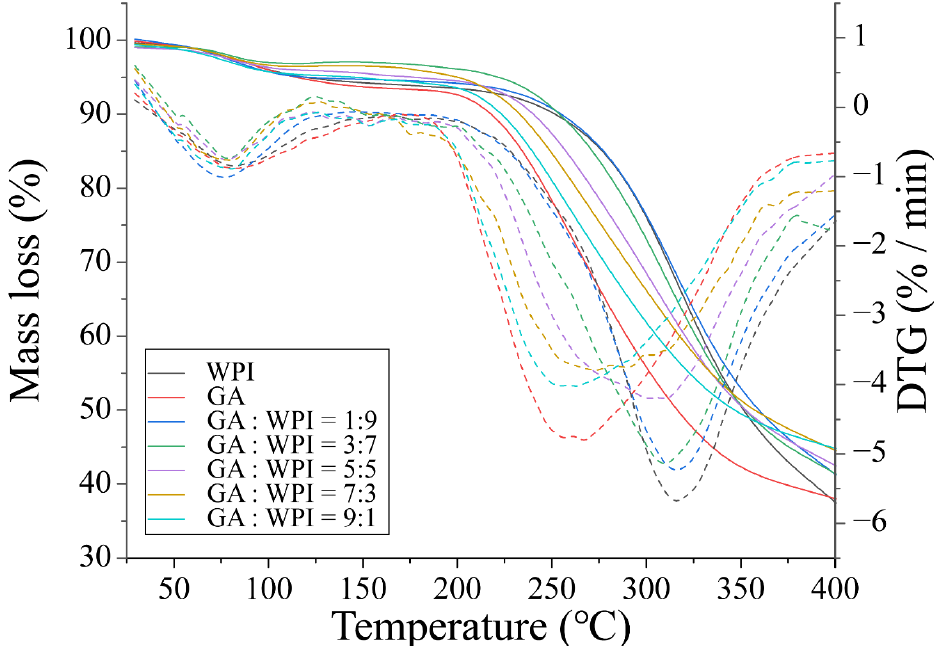
Figure 4. TGA and DTG patterns of GA, WPI and microcapsules are covered with different ratios of GA:WPI. Table 4. The maximum weight loss temperature (T m ) and mass loss (%) of GA, WPI and microcap- sules are covered with different ratios of GA:WPI.